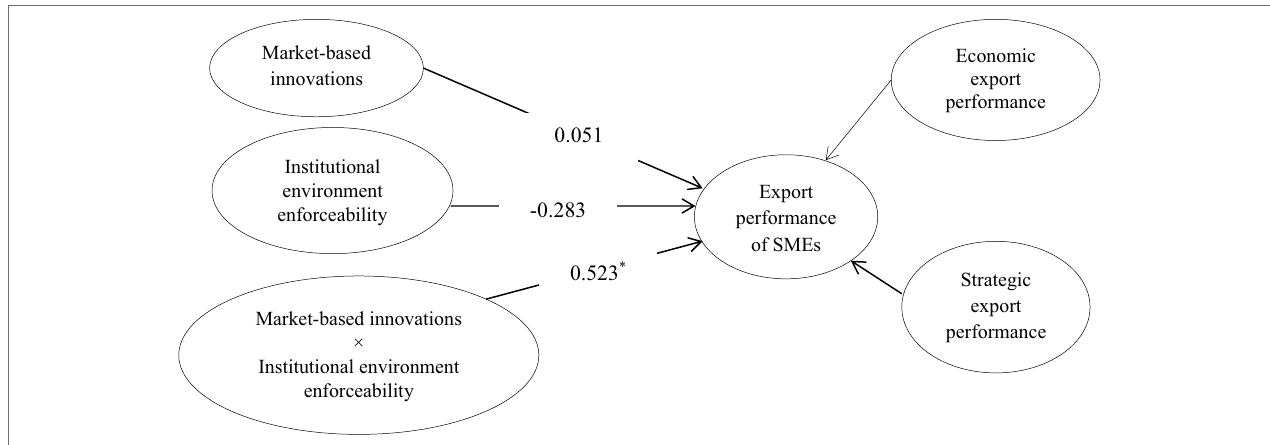
11.522.533.544.55